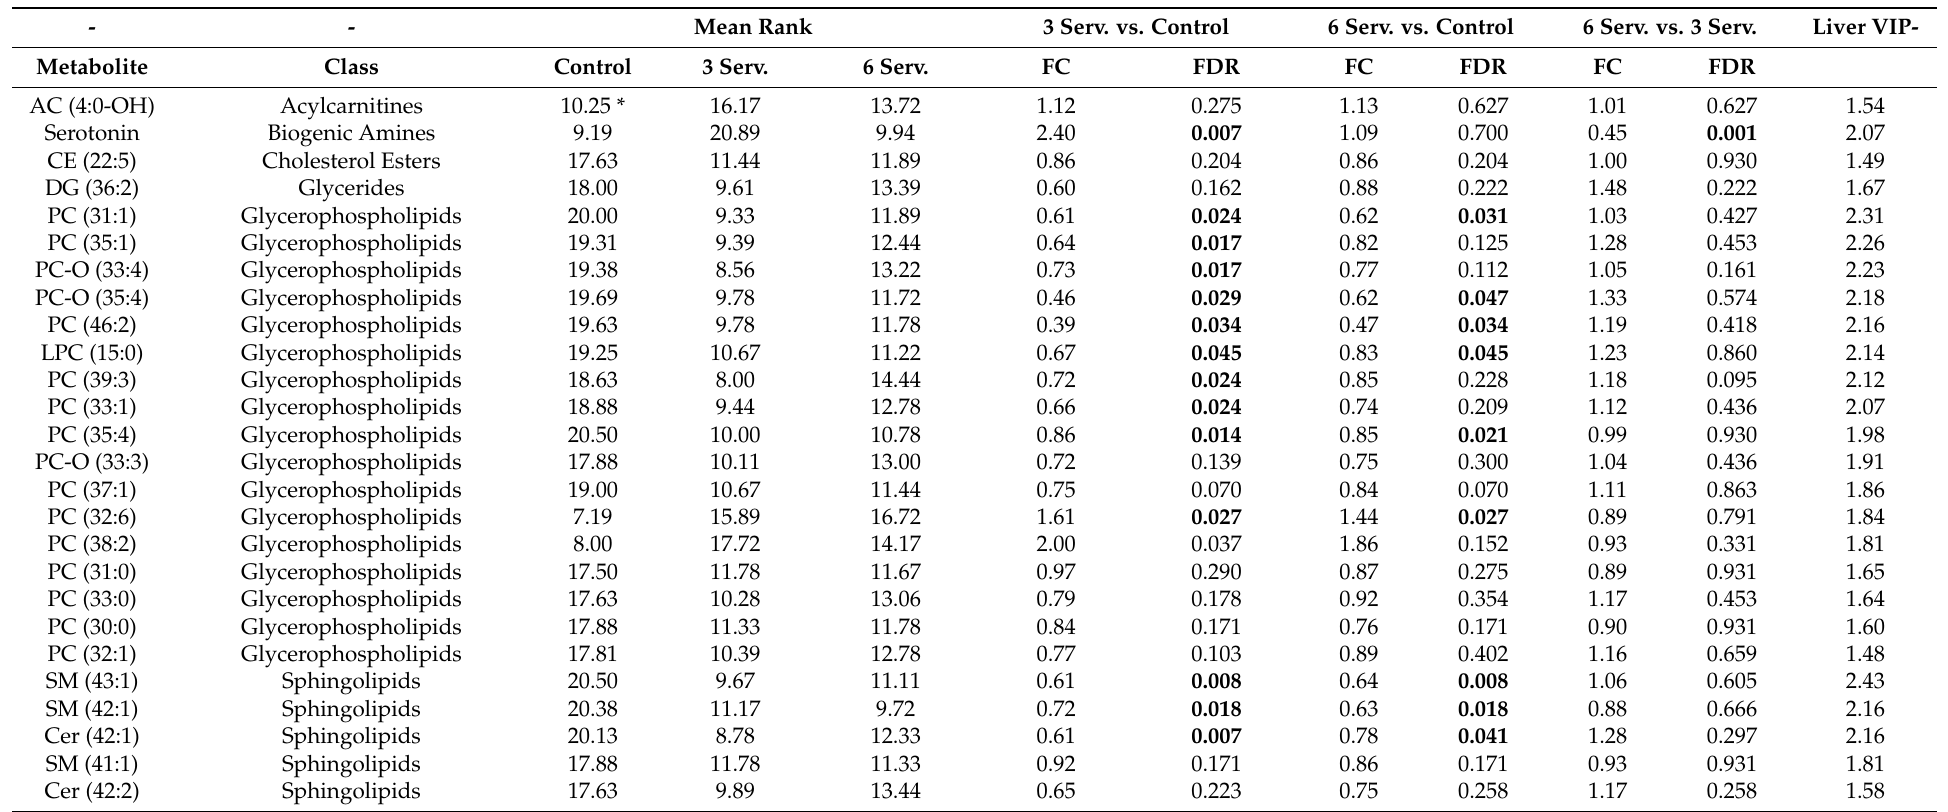
Table 4. Liver metabolite differences among treatment groups.